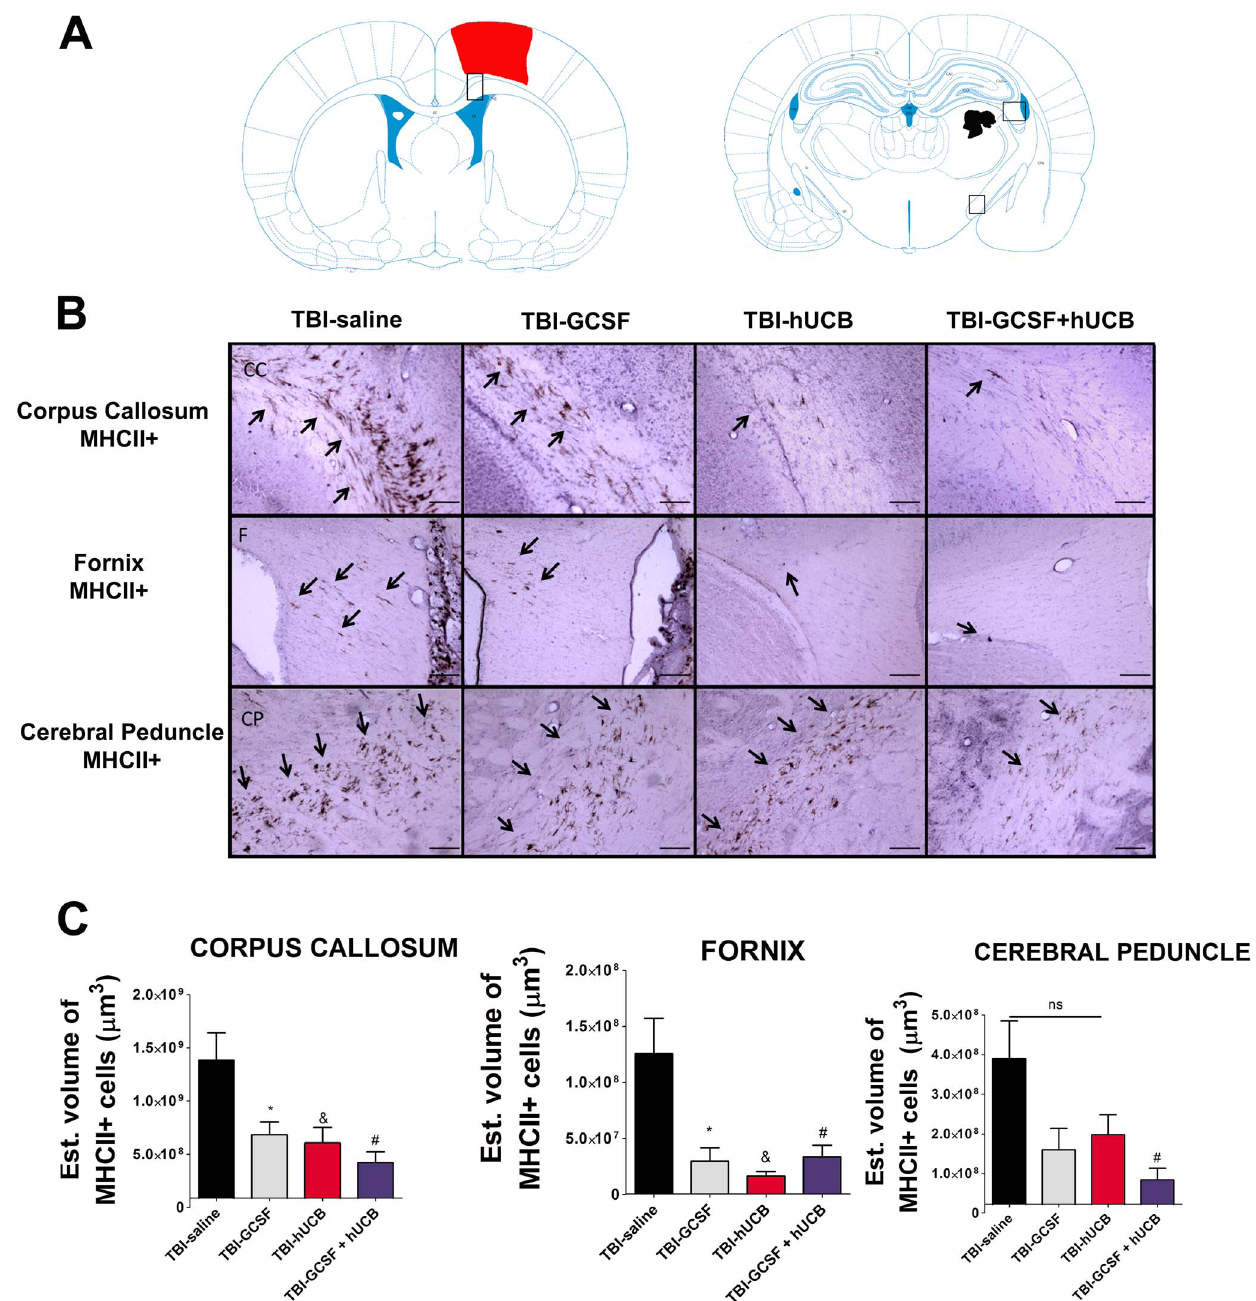
Figure 2. Monotherapy of hUCB or G-CSF, and hUCB + G-CSF combined therapy ameliorate TBI–induced neuroinflammation in white matter areas. Downregulation of activated microglia cells in the ipsilateral side of white matter axonal regions after treatment with hUCB alone, G- CSF alone, and combined hUCB + G-CSF relative to TBI-saline. Diagram of a coronal section shows the axonal lesion areas. The squares indicate the region of interest for analyses (Fig. 2A). Photomicrographs of white matter areas: corpus callosum, fornix, and cerebral peduncle of coronal sections from all four groups (Fig. 2B). Arrows indicate positive staining for activated microglia cells. Quantification of OX-6 immunostaining reflects estimated volume of activated microglia cells in corpus callosum, fornix, and cerebral peduncle (Fig. 2C). Corpus callosum, F3,20=14.6, p , 0.0001; fornix, F3,20=9.017, p , 0.0001; cerebral peduncle, F3,20=4.638, p , 0.0001. Scale bar for B=1 m m. *=significant difference between TBI-saline and TBI-G- CSF; &=significant difference between TBI-saline and TBI-hUCB; # =significant difference between TBI-saline vs TBI-hADSC; ns=no significance. Significance at p’s , 0.05. doi:10.1371/journal.pone.0090953.g002 synergy of the combined therapy is not present since the monotherapy of G-CSF. Investigations on the neurogenic monotherapy of hUCB cells equally decreased the neuronal cells potential of present treatments revealed that monotherapy of hUCB cells or G-CSF, and the combined therapy of hUCB + G- death in this area of the hippocampus relative to saline alone and